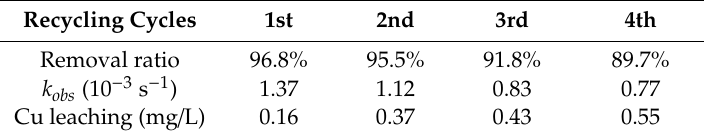
Figure 13. Recycling performance of the Cu / Al 2 O 3 / CN composite for Rh B degradation in the presence of 1 g / L of the Cu / Al 2 O 3 / CN composite. Reaction conditions: [Rh B] 0 = 10 mg / L, [H 2 O 2 ] 0 = 10 mM, V = 100 mL, 25 ◦ C, pH 4.9 (unadjusted). Table 4. k obs and Cu leaching in the recycling experiments.